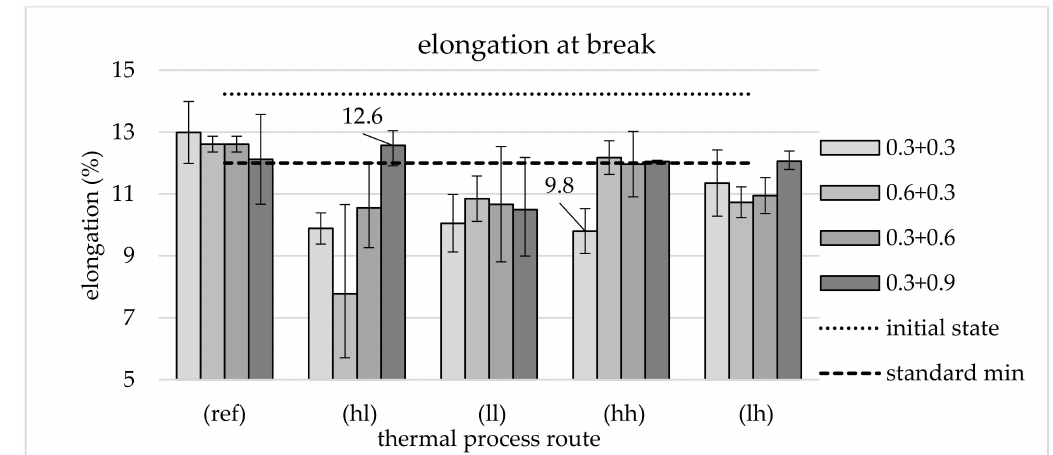
Figure 8. Elongation at break: initial state, reference, di ff erent TMT routes and requirement of the standard, average of three tests and range of